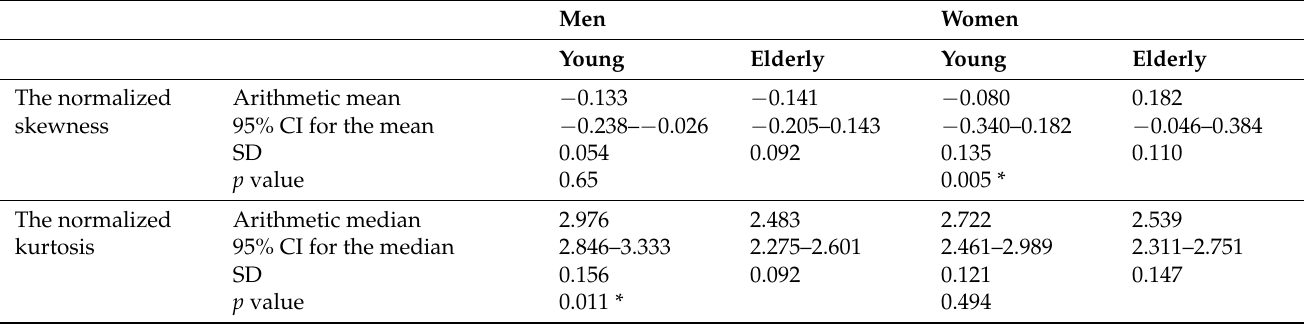
Table 3. Means, 95% CIs for the mean and median, and SDs for all parameters analyzed with higher-order statistics (HOS). Men Women Young Elderly Young Elderly The